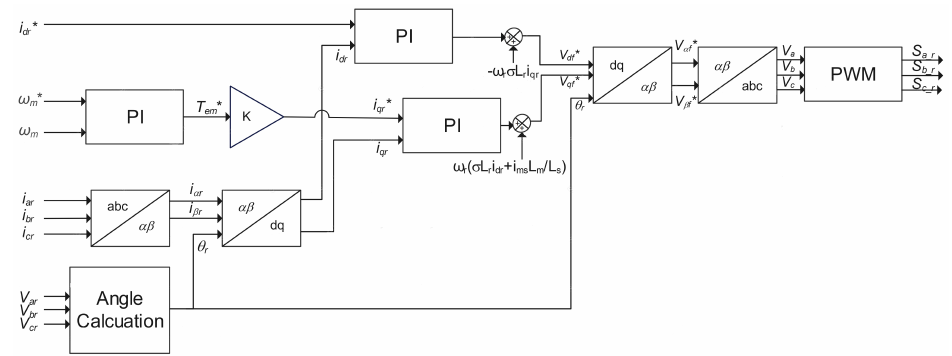
Figure 4. Vector control of rotor-side